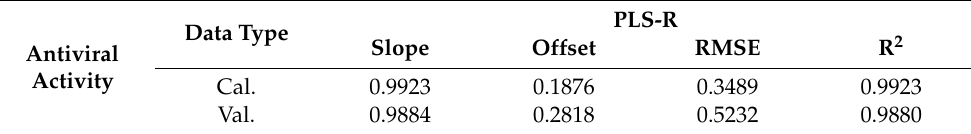
Figure 3. PCA score plot ( a ) and loading plot ( b ) based on GC-MS chemical profile of the volatile of fresh ginger (FG) and dry ginger (DG). oils of fresh ginger (FG) and dry ginger (DG). Table 4. PLS-R model parameters used for